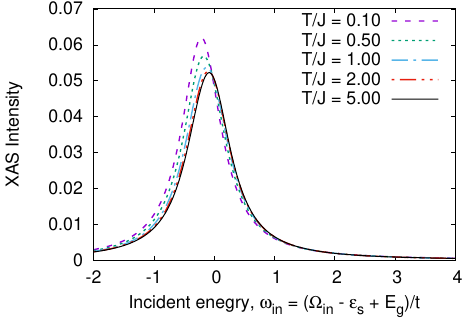
Figure 11. T -dependence of XAS spectrum in a “Cu-O-Cu”